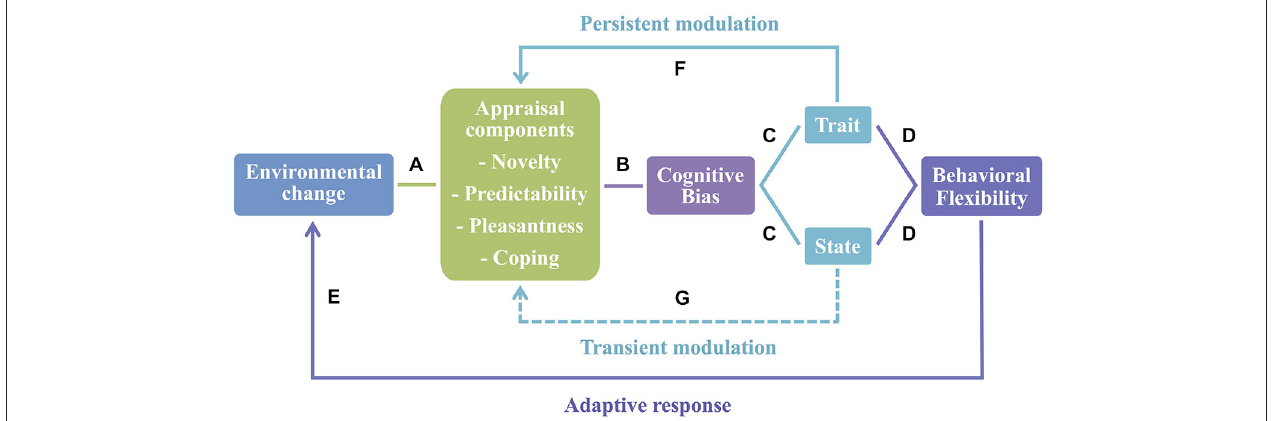
and as a trait it is consistent over time with different individuals exhibiting a specific phenotype—between-individual variability (e.g., optimistic/pessimistic). (D) Both mechanisms are characteristic of behavioral flexibility. (E) These behavioral flexibility processes promote an adaptive response to new environmental changes that may occur. (F) Conversely, the appraisal process may be subject to a long-lasting modulation by cognitive bias as a trait, and short-term effects (G) are expected when cognitive bias occurs as a